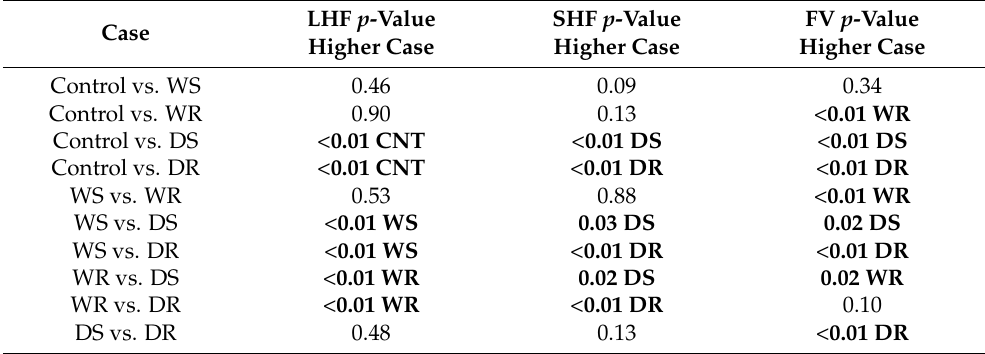
Table 5. As in Table 4 for